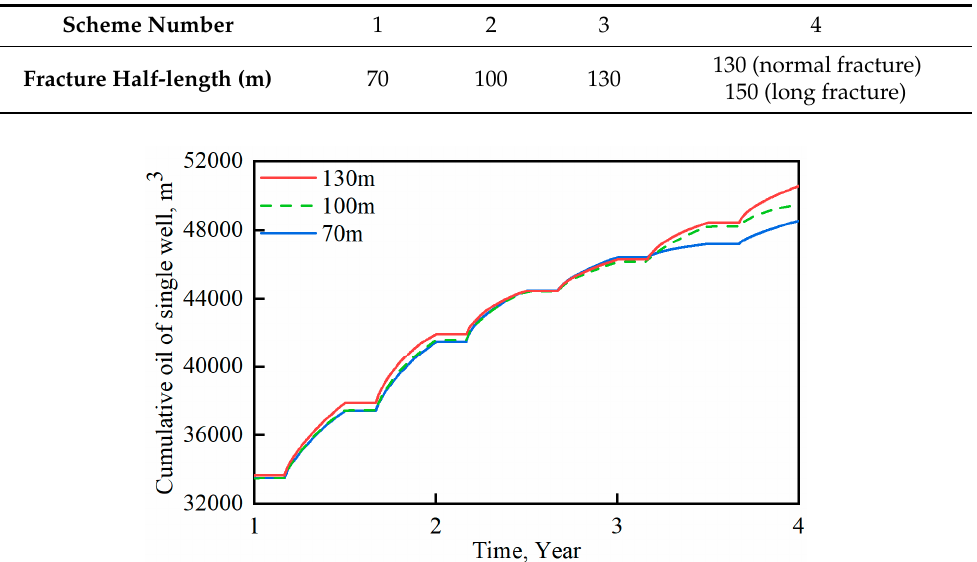
Figure 15. Comparison of cumulative oil production of the single well in each scheme under different fracture lengths.